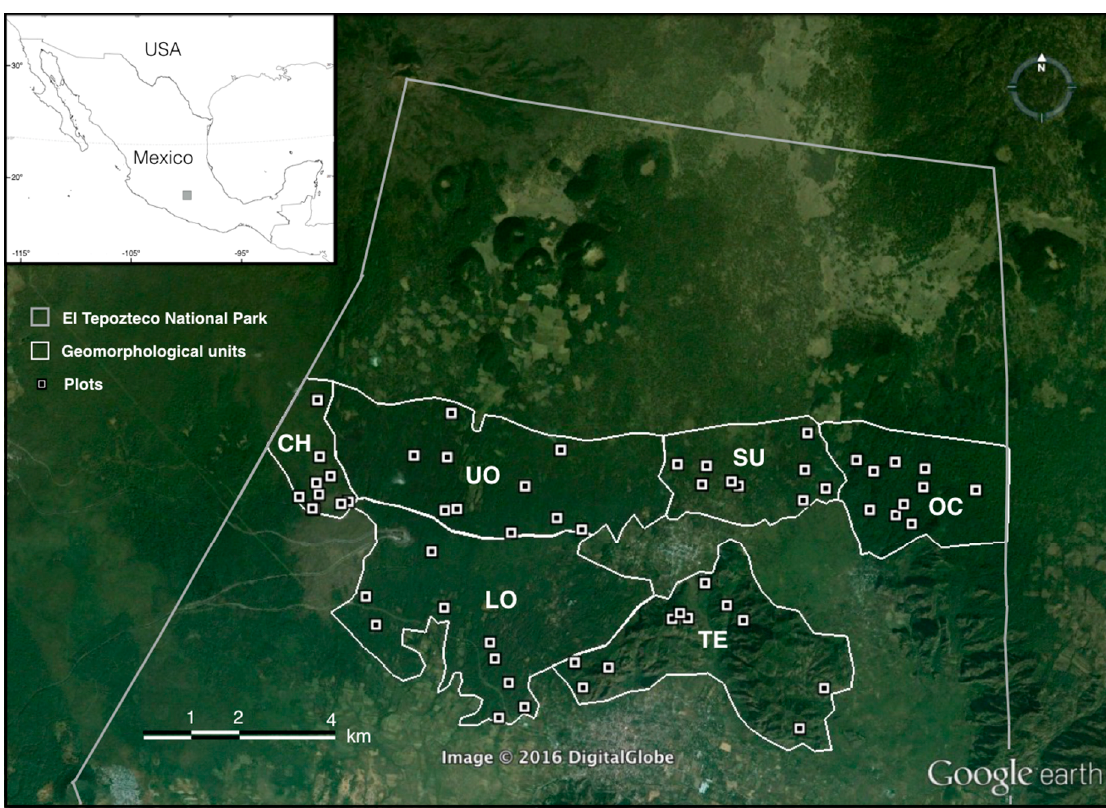
Figure 1. Google Earth image of the study site captured on January 2005, showing limits of El Tepozteco National Park (Mexico) and location of oak forest sampling plots in six geomorphological units: Chichinautzin (CH), Suchiooc (SU), Otates, divided into a lower (LO) and upper (UO) subunit, and Oclayuca (OC). Extreme coordinates of this scene are 18.977°–19.099°N, 99.024°–99.201°W. Actual geomorphological units are larger than the polygons shown here, as these only depict the extent of oak forest in these units.